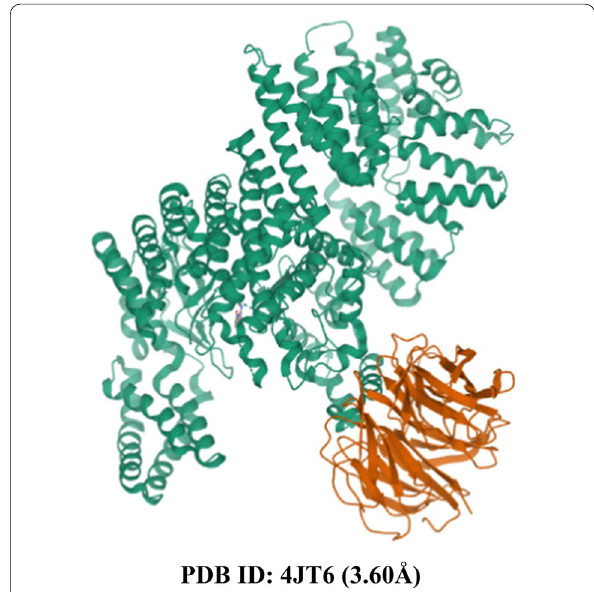
Fig. 1 Prepared structures of the target Table 2 Name, binging score and contributions of interaction energies to the binding affinity